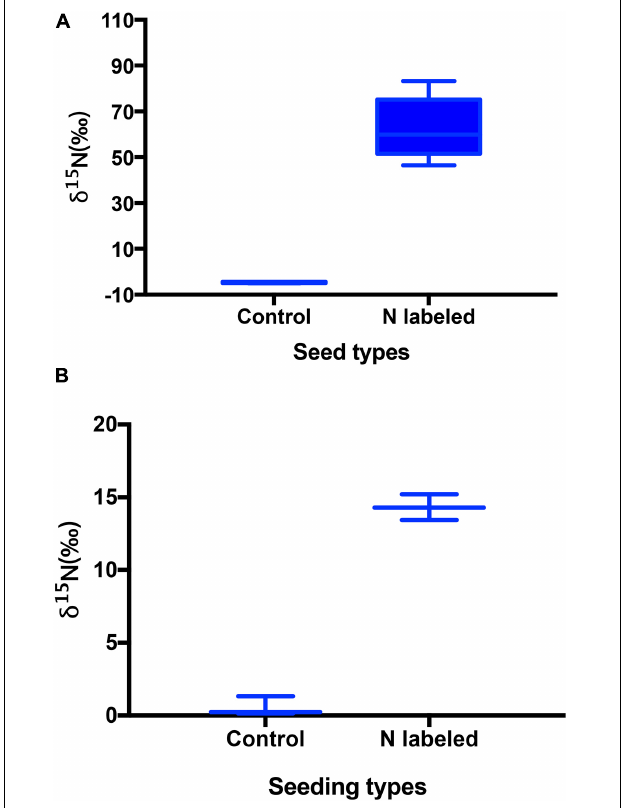
FIGURE 1 | Effects of xylem injection of 15 NH 4 Cl and K 15 NO 3 on 15 N enrichment of acorns (A) and seedlings (B) . Box plots show the median, upper (25%), and lower quartile (25%) of data and whiskers indicate the maximum and minimum values, with the exception of outliers, and the same